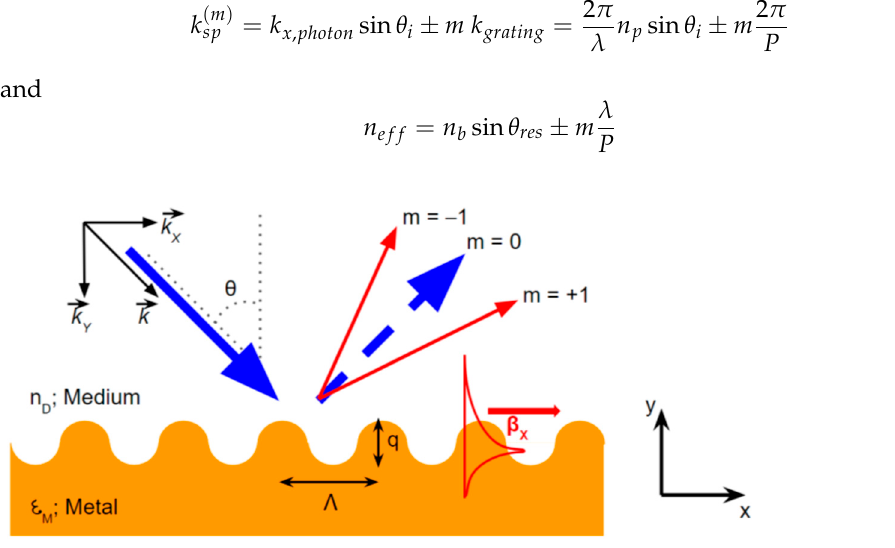
Figure 16. Schematic diagram of the grating-based SPR biosensor (adapted with permission from Reference [73], copyright MDPI). Reference [73], copyright